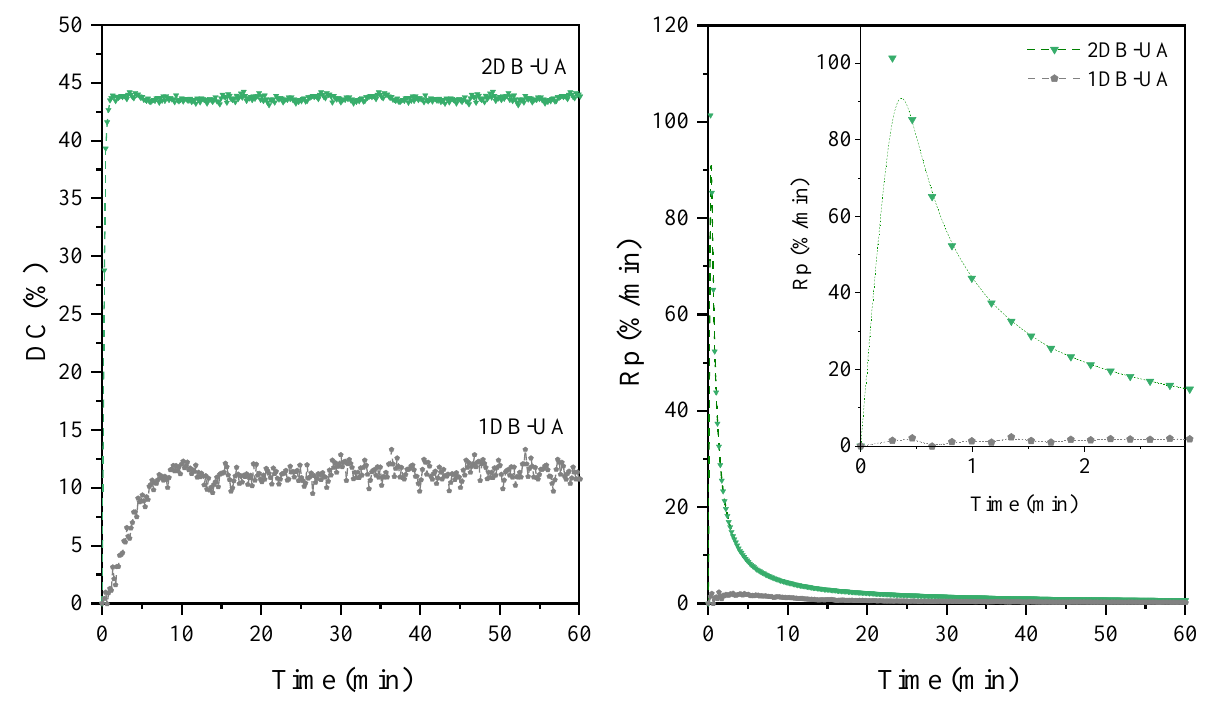
Figure 6. The unsaturated double bond conversion (DC) and the photopolymerization rate (Rp) of various UA resins. Table 3. The basic properties of the cured coatings based on various UA resins.